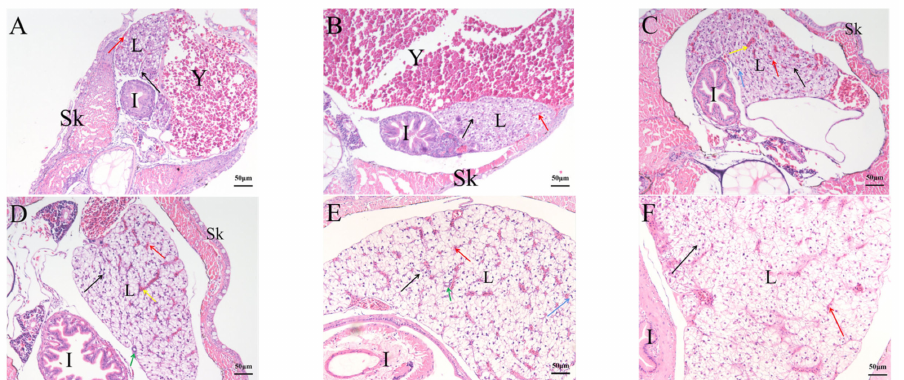
Figure 9. Hematoxylin and eosin staining of histological sections of the rice-field eel liver during development from 2 dph to 45 dph. ( A ): 2 dph; ( B ): 6 dph; ( C ): 17 dph; ( D ):24 dph; ( E ): 30 dph; ( F ): 45 dph. Bars: 50 µ m. Black arrow: hepatic cord. Red arrow: hepatic sinusoid. Yellow arrow: central vein. Blue arrow: binuclear hepatocytes. Green arrow: bile canalicular. L: liver. Y: yolk. I: intestine. Sk: skin. Sections were stained with